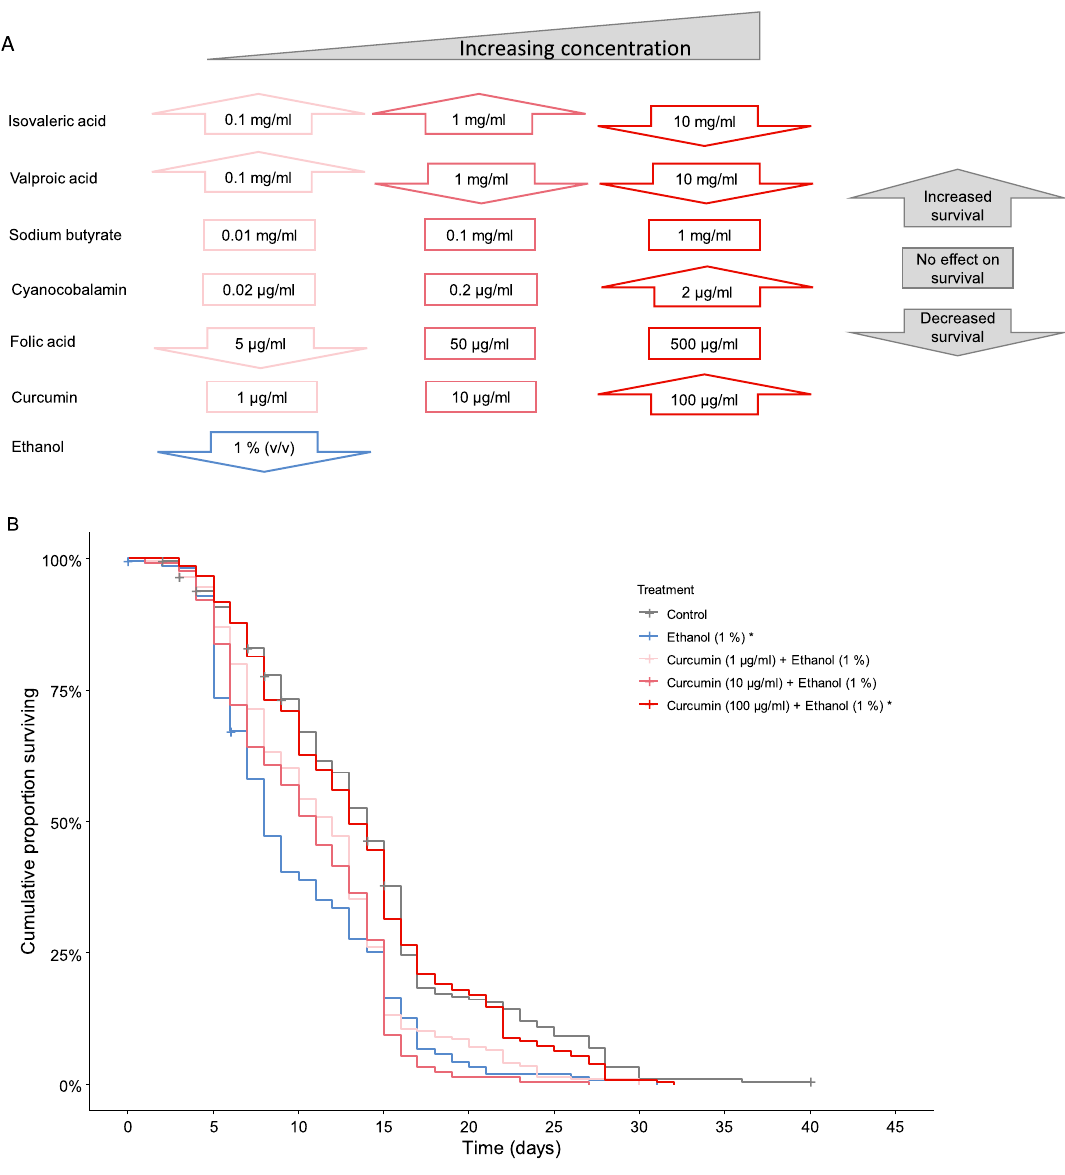
Figure 2. Effects of bioactive food compounds on honey bee survival. ( A ) Overview of all substances studied and the selected concentrations used in the feed. Upward pointing arrow signifies increased life span, rectangular box, no statistical effect on life span, downward pointing arrow signifies shorter life span ( p < 0.05 Pair-wise Log-Rank test corrected using FDR). ( B ) Kaplan–Meier plot of survival curves of ethanol (1% (v/v)) alone and in combination with curcumin at 1, 10 and 100 µg/ml. Pluss signs indicate censored honey bees. Asterisks in legends indicates significant effects on survival compared to